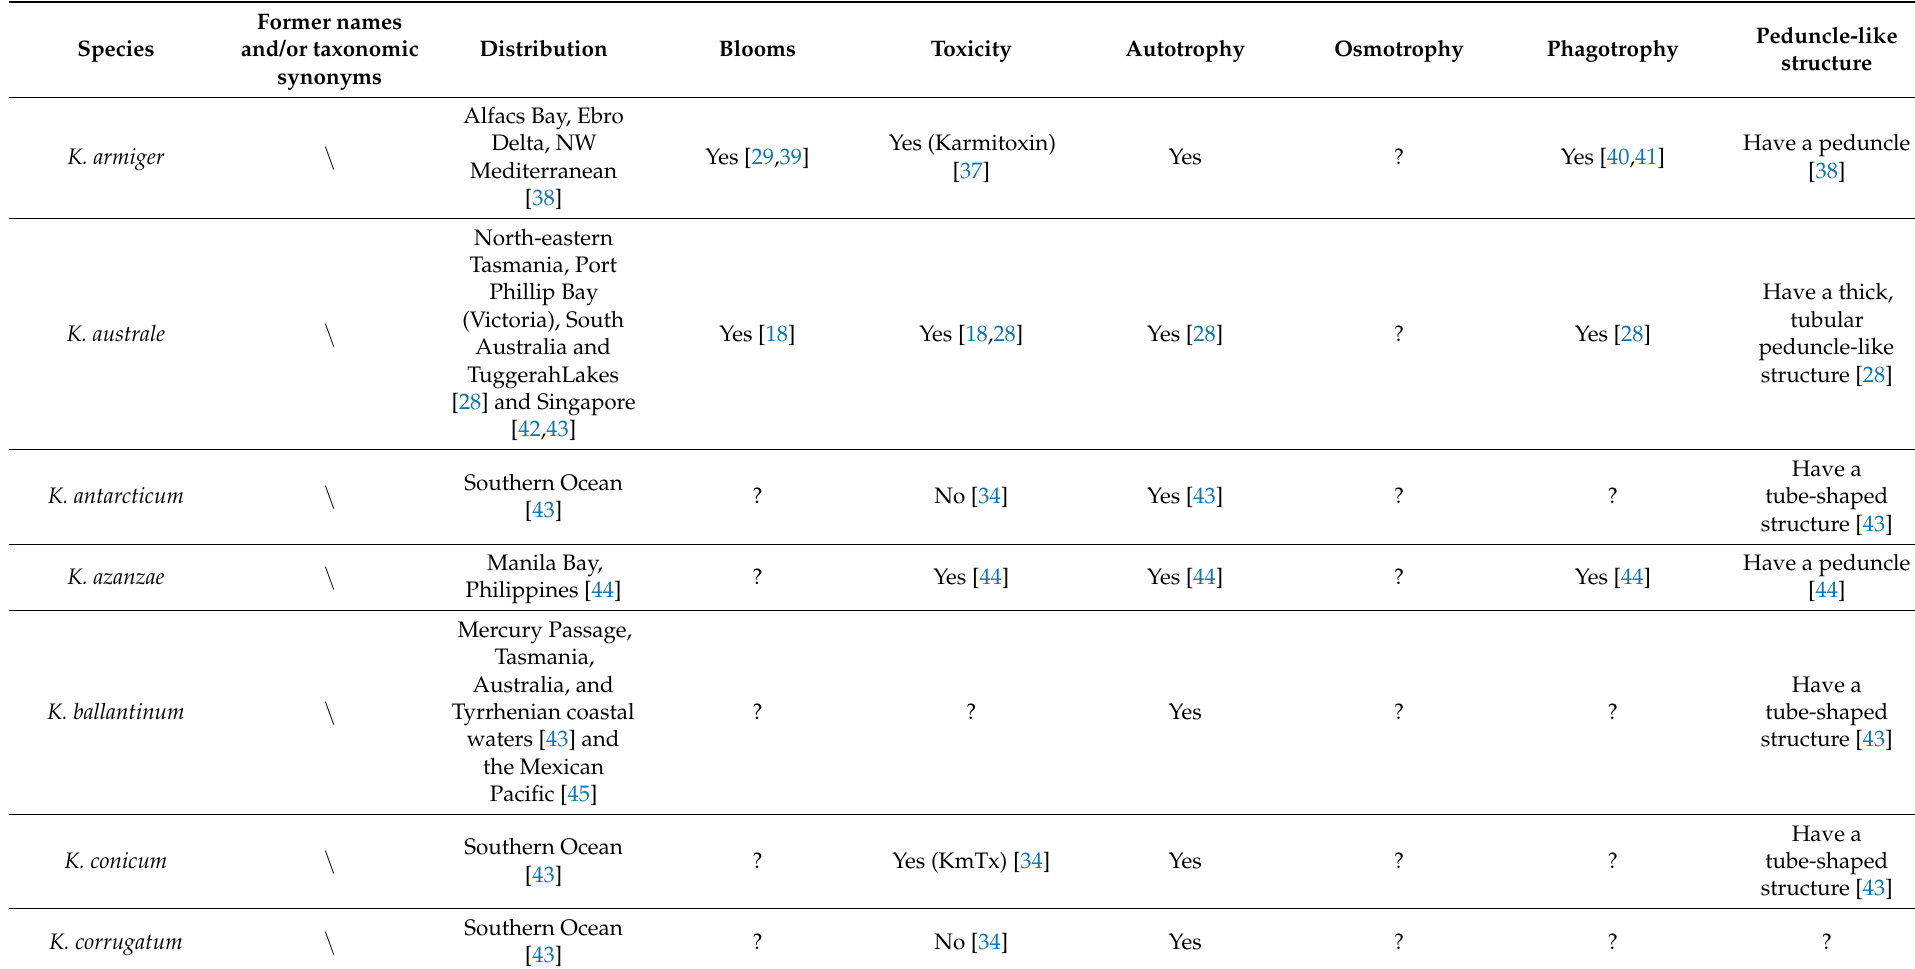
Table 1. A collection of Karlodinium species regarding their bloom threat, toxicity, trophic modes, and associated mechanisms.